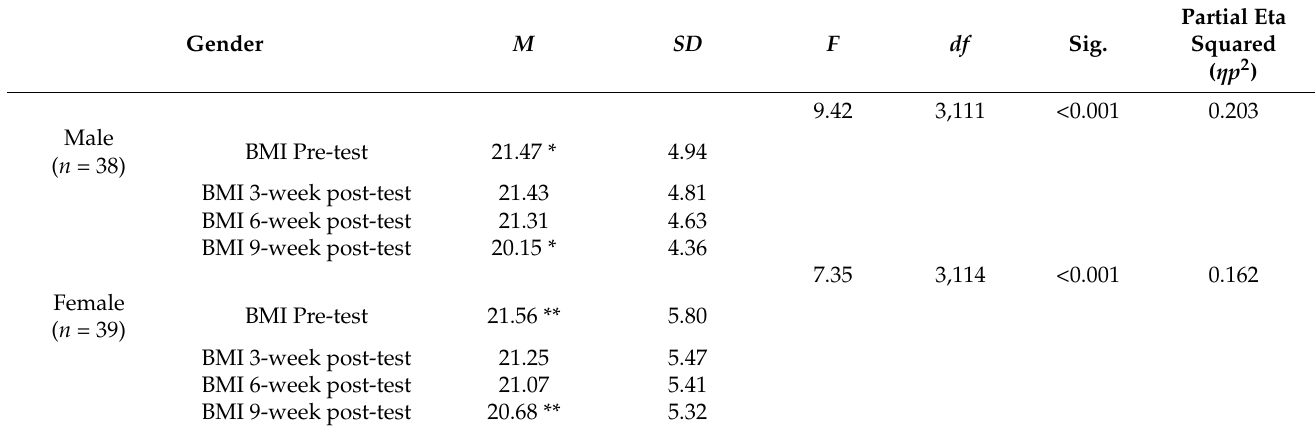
Table 2. One-way repeated measures ANOVA for the effect of nine-week skipping on